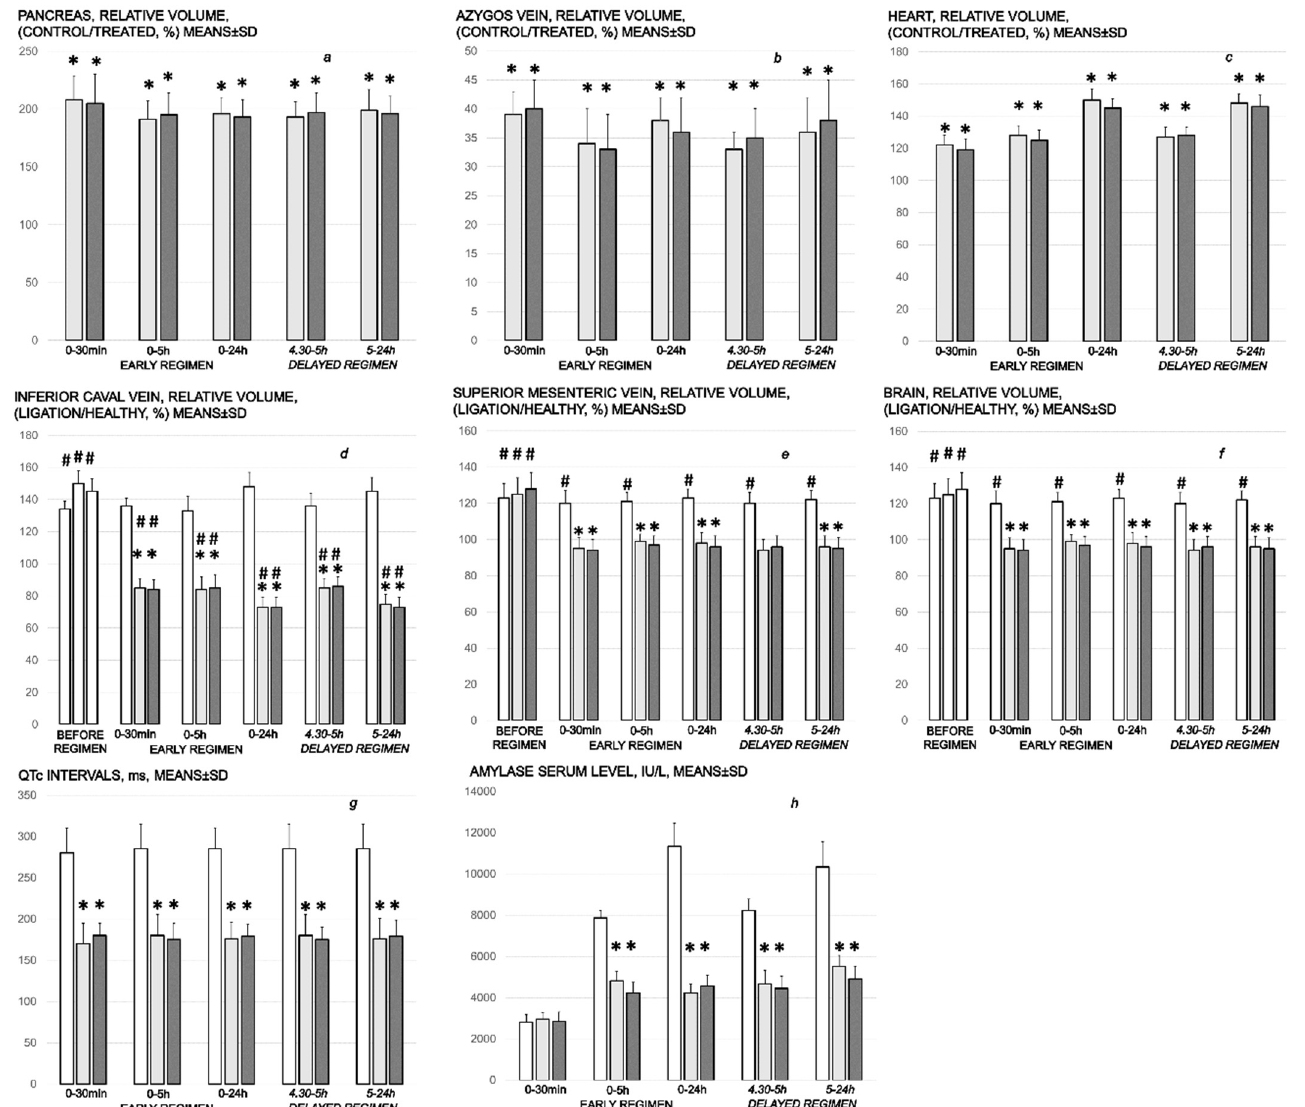
Figure 2. Timeline of relative volume ( a – f ) of the QTc intervals, ms ( g ), and serum amylase level, IU/L ( h ). Presentation of the relative volume of the pancreas ( a ), azygos vein ( a ), heart ( c ), inferior caval vein ( d ), superior mesenteric vein ( e ), and brain ( f ) to illustrate the effect on pancreas swelling, brain swelling, heart dilatation, superior mesenteric vein and inferior vein congestion, azygos vein failure, and counteraction as control/treated % or ligation/healthy % at the end of the ligation time period of 30 min, 5 h, and 24 h, as an early regimen at 0–30 min ( e ), 0–5 h ( f ), and 0–24 h ( g ) of application-sacrifice period, and as delayed regimen at 4.30 h–5 h ( h ) and 5 h–24 h application-sacrifice period. Therapy included BPC 157 (10 μ g/kg (light gray bars) or 10 ng/kg (dark gray bars)) or saline (5 mL/kg) (white bars) as an intragastric administration either immediately following ligation or as an early regimen, for assessment at 30 min, 5 h and 24 h ligation time. As a delayed regimen, the therapy was given as an intragastric administration at 4.30 h ligation time for assessment at 5 h ligation time, or as oral administration, continuously in drinking water from 5 h ligation time until sacrifice at 24 h ligation time. Means ± SD, * p ˂ 0.05, at least, vs. control, # p ˂ 0.05, at least, vs. healthy.